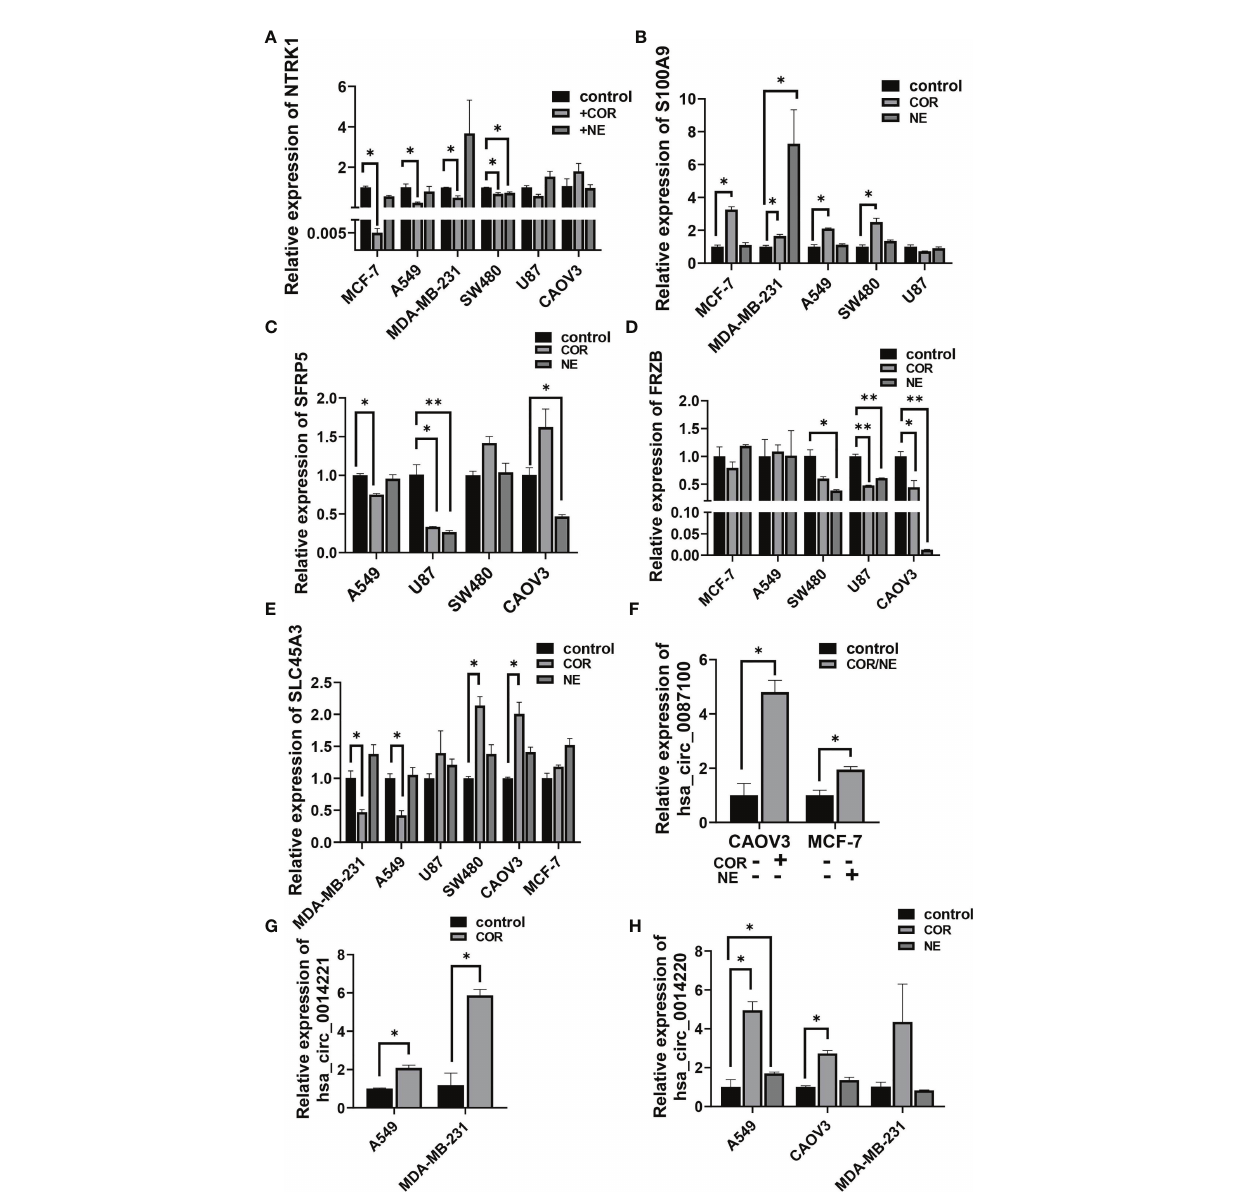
FIGURE 7 | Stress hormones alter the expression of cancer-related genes in various cancer cell lines. qRT-PCR analysis of the relative expression of NTRK1 (A) , S100A9 (B) , SFRP5 (C) , FRZB (D) , SLC45A3 (E) , hsa_circ_0087100 (F) , hsa_circ_0014221 (G) , and hsa_circ_0014220 (H) in A549, MCF-7, SW480, U87, CAOV3, and MDA-MB-231 cell lines by NE (10 µM) and/or COR (10 µM) treatment for 48 h * p < 0.05, ** p <